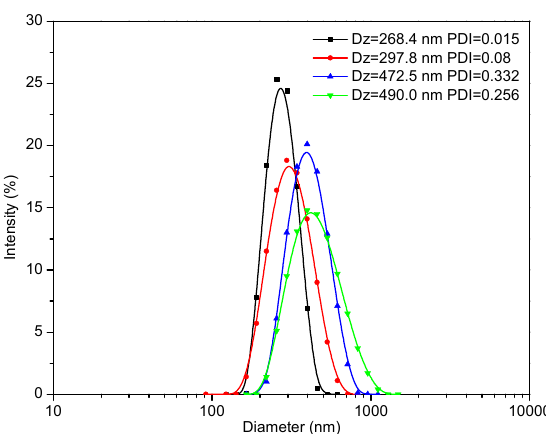
Figure 1. Hydrodynamic particle size of silica ( black ), silica@BA ( red ), horseradish peroxidase (HRP)-imprinted MIP ( blue ), non-imprinted polymer (NIP) ( green ) measured in water.